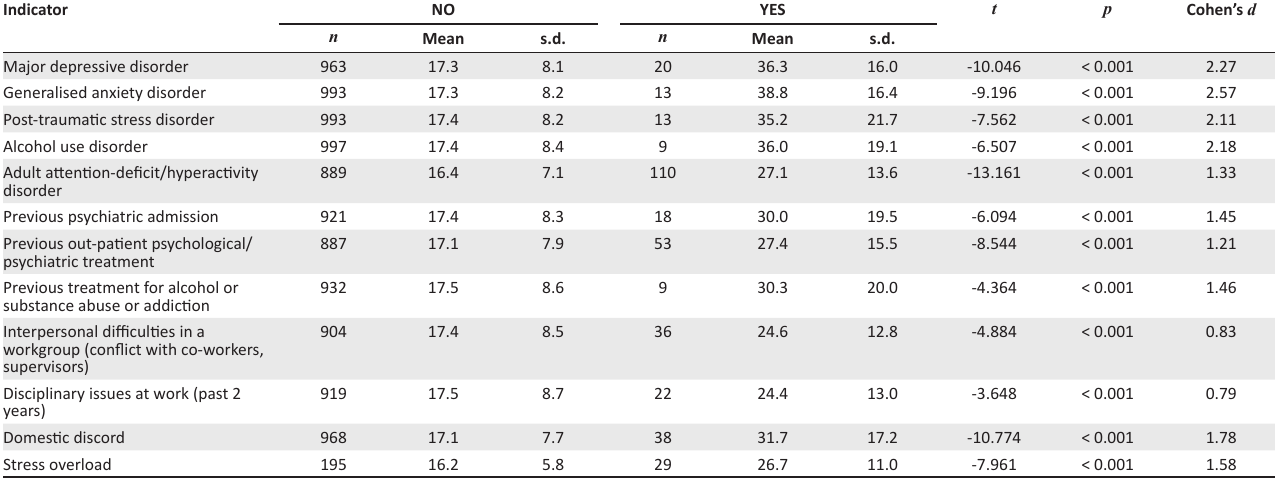
TABLE 3: T -test for independent samples for Emotional Dysregulation Scale-Short Form and selected indictors of common mental disorders and other adjustment difficulties.